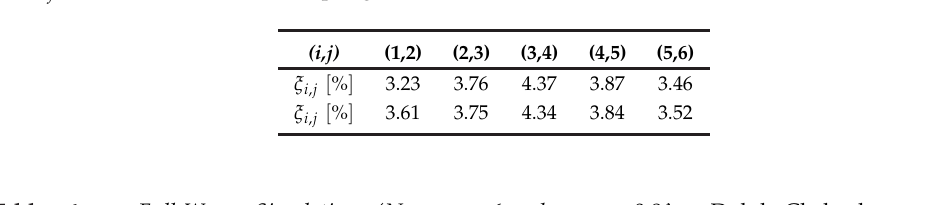
Table 3. Full-Wave Simulation ( N = 6, d = 0.8 λ ; Dolph–Chebyshev pattern: SLL ref = − 30 dB)—Mutual coupling coefficients.